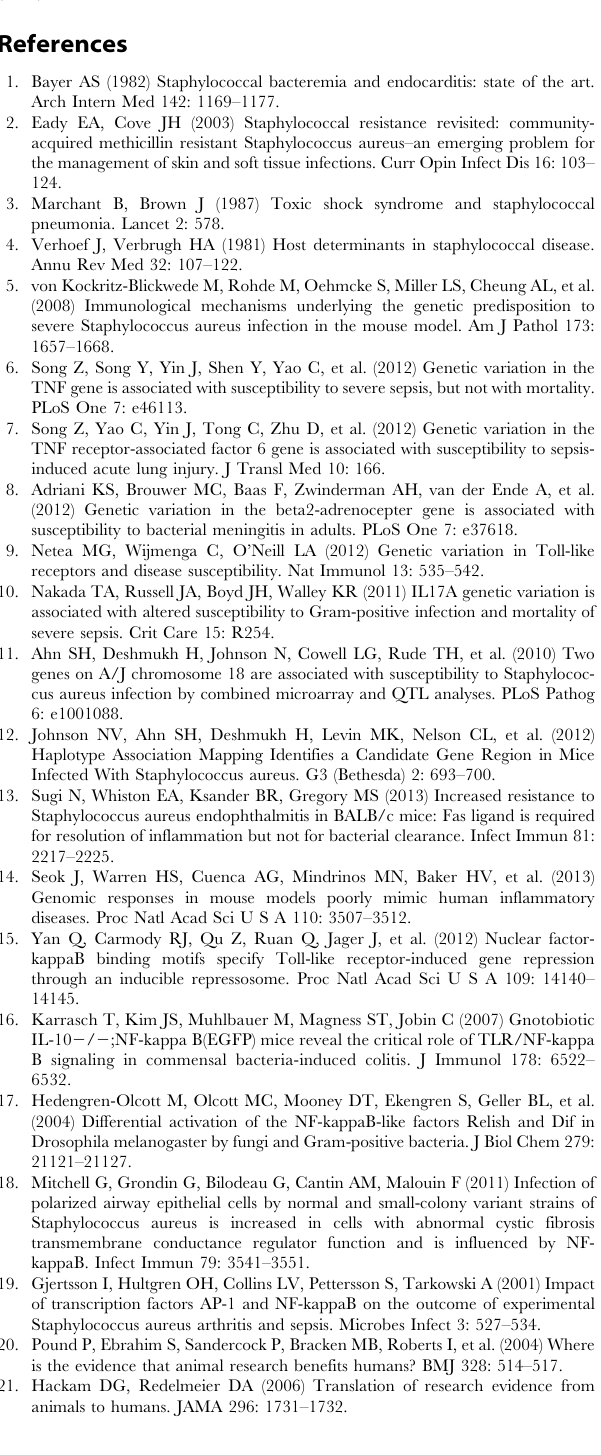
Table S1 List of qPCR primers for candidate genes. (TIF) Table S2 List of siRNAs used in this study. (TIF) Table S3 List of antibodies used in this study. (TIF) Table S4 List of qPCR primers for cytokines and chemokines applied used in this study.